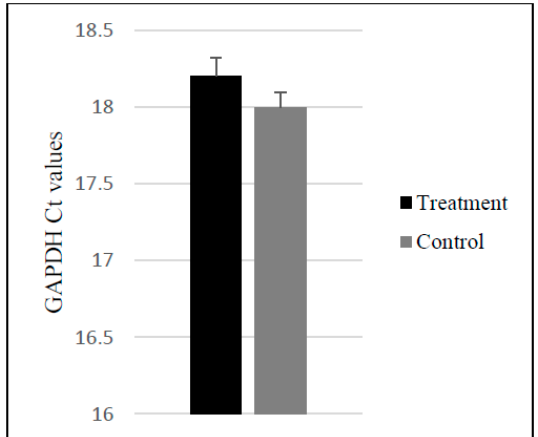
Figure 10. Glyceraldehyde 3-phosphate dehydrogenase (GAPDH) C t values were not significantly different between treatment and controls.